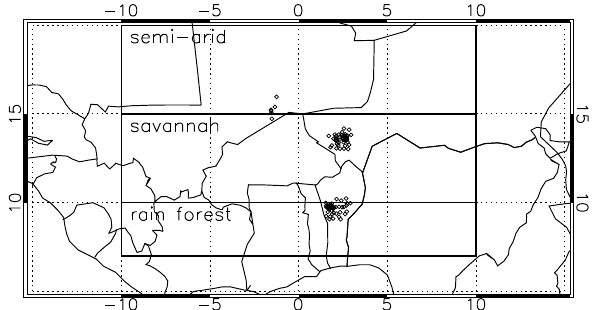
Fig. 2. Locations of the 110 selected AMMA rain gauges, which were used for the validation of the CPP-PP rain retrievals, and Fig.2. Locationsofthe110selectedAMMAraingauges, whichwereusedforthevalidationoftheCPP-PP rainretrievals,andthethreeregions(designated’rainforest’,’savannah’,and’semi-arid’)usedforcalculating the three regions (designated “rain forest”, “savannah”, and “semi- theCPP-PPandCMORPHdaytimecycle. arid”) used for calculating the CPP-PP and CMORPH daytime